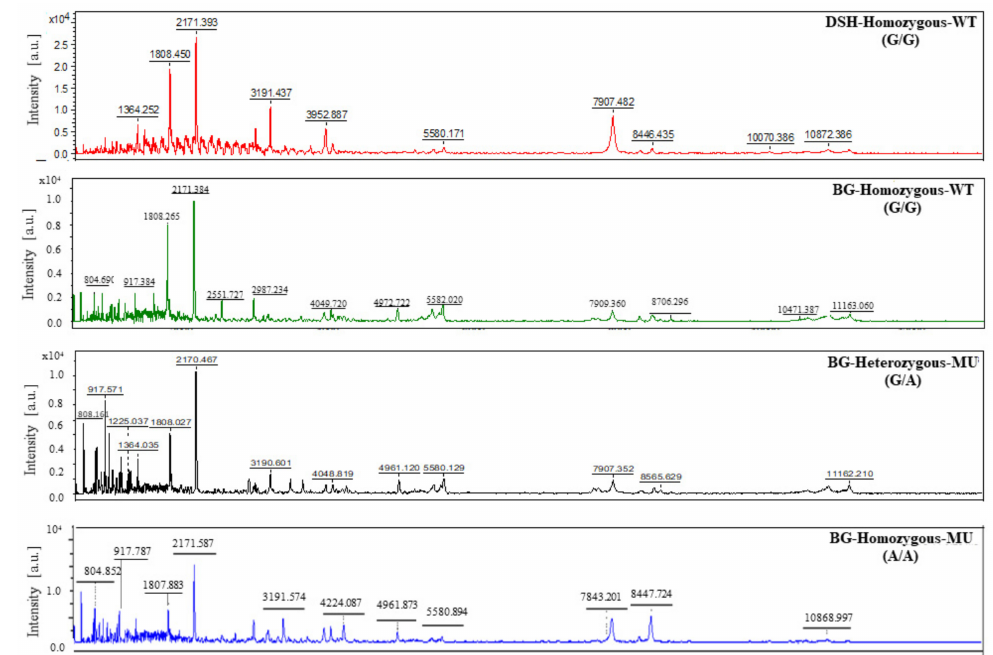
Figure 7. Peptide mass fingerprint (PMF) of the isolated protein from the serum of the study animals. DSH = Domestic short hair; BG = Bengal cat; WT = wild-type; MU =